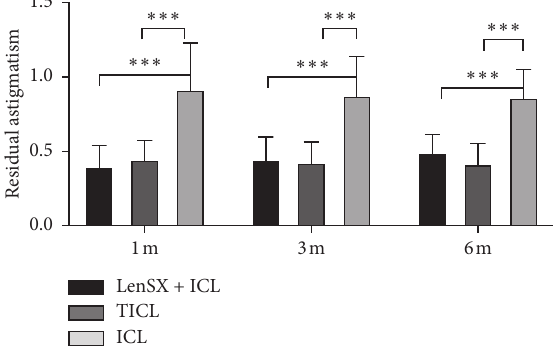
Figure 6: The comparison of postoperative residual astigmatism in three groups at 1, 3, and 6 months (the results are expressed as means ± SD and ∗∗∗ P < 0 .